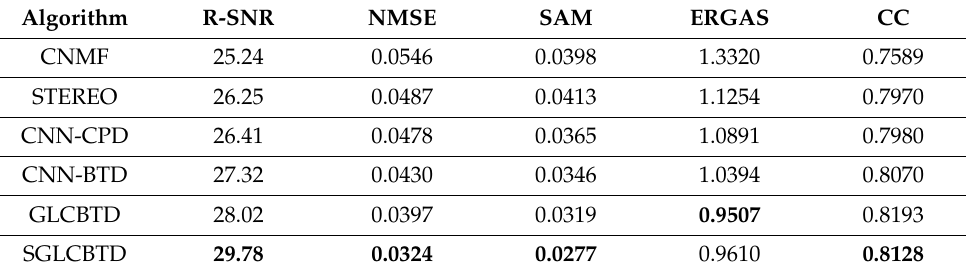
Table 1. Quantitative indices comparison on the Indian Pines